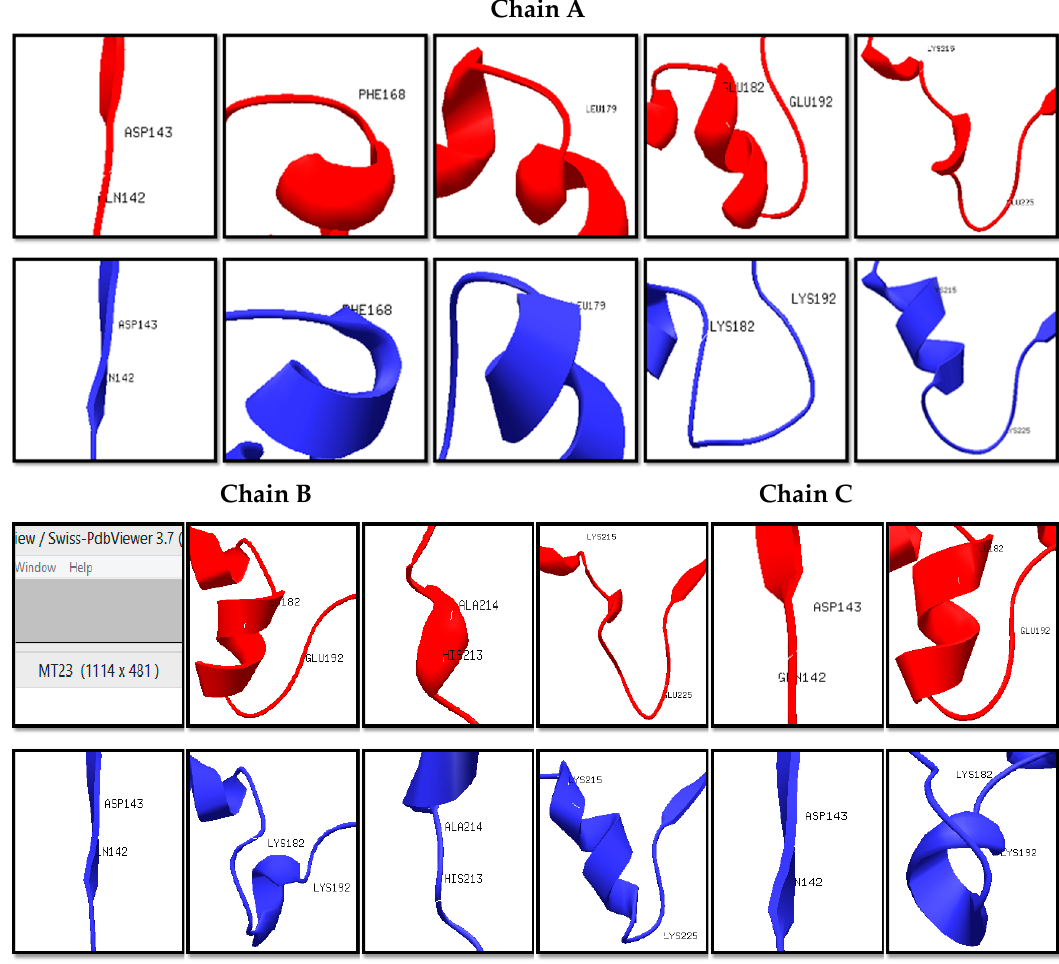
Figure 2. Structural differences of specific amino acid residues (red: Wt; blue: Mut23).